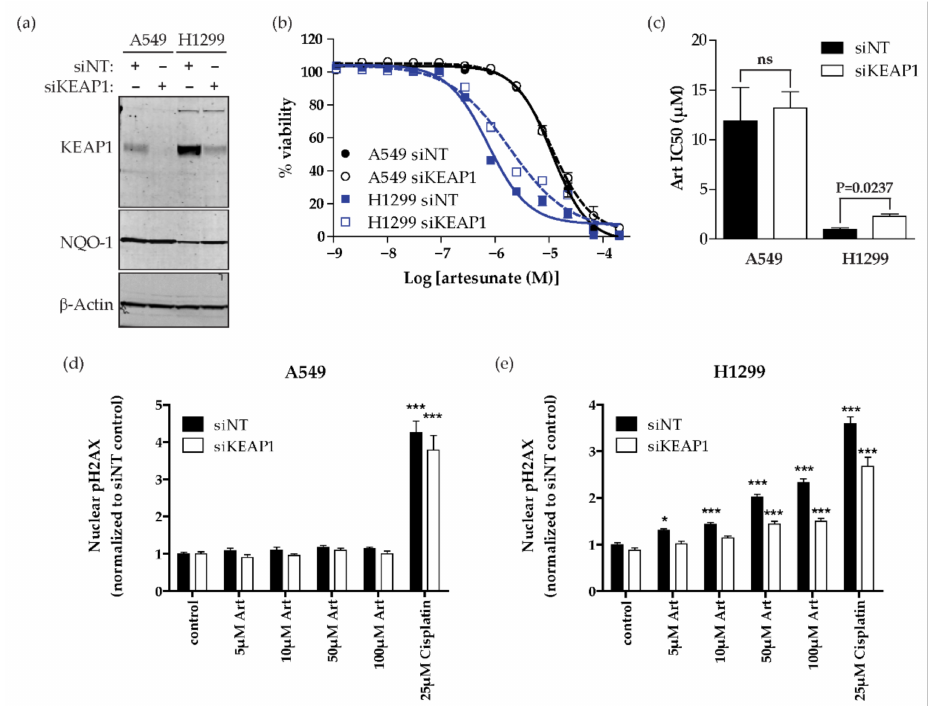
Figure 4. Knocking down KEAP1 increases resistance to artesunate in H1299 cells ( a ) Western blot analysis for KEAP1, NQO-1 and ß-Actin shows reduced KEAP1 protein in siKEAP1-treated cells 48 h after transfection. ( b ) Artesunate dose–response curves after transfection with non-targeting (siNT— solid) or KEAP1 (siKEAP1—dashed) siRNA. Data was normalized to 0.1% DMSO and is plotted as mean ± SD, n = 4. ( c ) The mean IC50 of artesunate in each cell line transfected with non-targeting (siNT) siRNA (solid) or siKEAP1 (open) is graphed ± SD. p -values were calculated using a two-tailed t -test. ( d , e ) Quantification of nuclear pH2AX staining in A549 ( d ) and H1299 ( e ) following transfection with siNT or siKEAP1. DNA damage was assessed by nuclear pH2AX staining after 24 h treatment with 0.1% DMSO (control), the indicated concentration of artesunate, or 25 µ M cisplatin. Nuclear pH2AX staining is was normalized to cells transfected with siNT and treated with DMSO control and is plotted as mean fold change ± SD. p -values calculate using a two-way ANOVA comparing each artesunate concertation to the matched control after normalization (* p < 0.05; *** p <